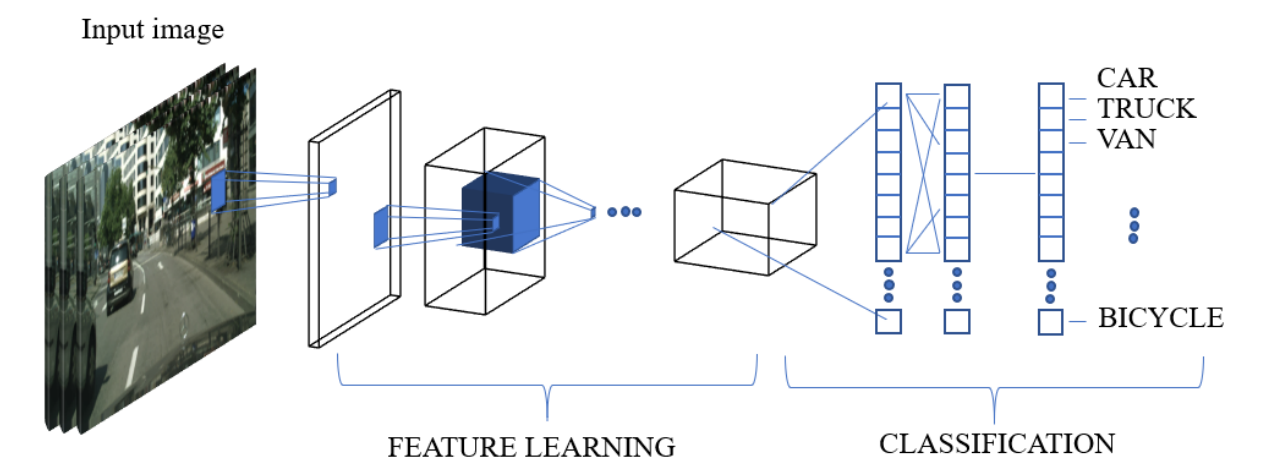
Figure 2. An example of a convolutional neural network